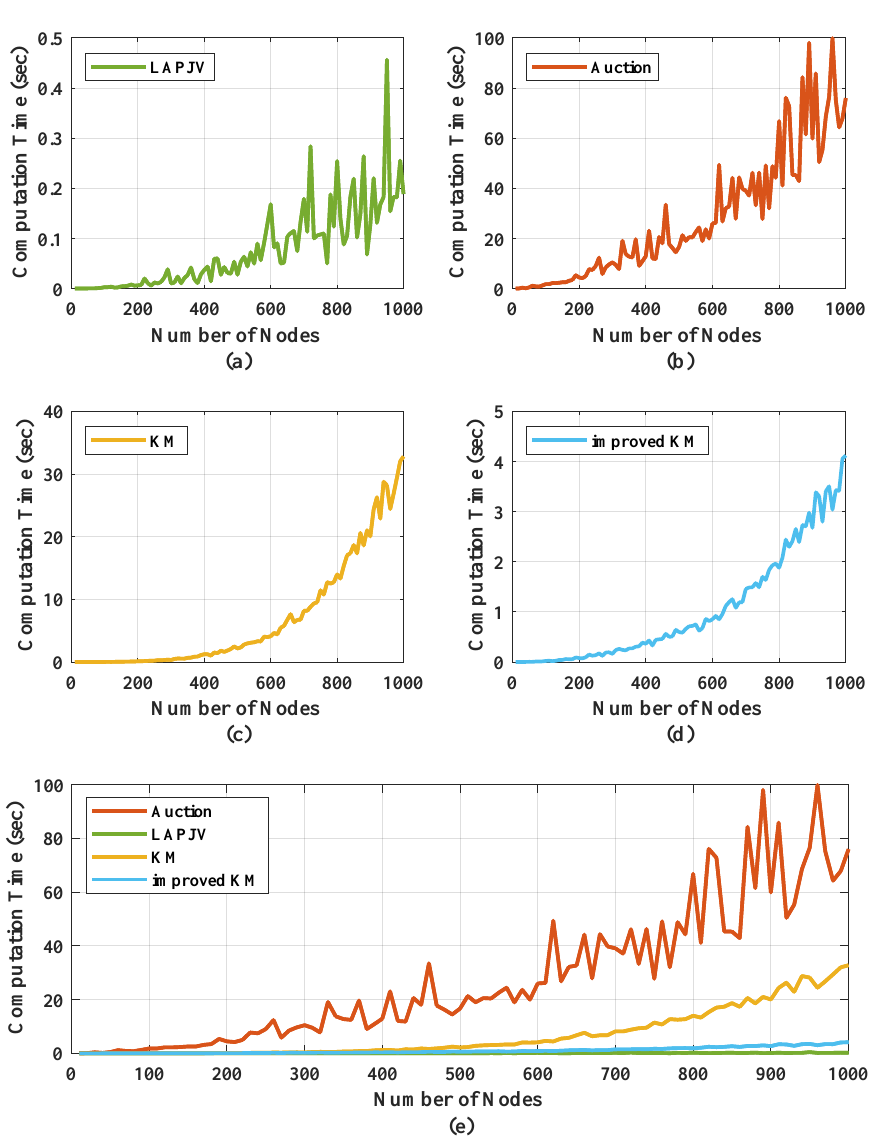
Figure 9. Computation time comparison between LAPJV, Auction, KM and improved KM as nodes varies from 10 to 1000. ( a ) Average computation time of the LAPJV algorithm; ( b ) Average com- putation time of the KM algorithm; ( c ) Average computation time of the improved KM algorithm; ( d ) Average computation time of the Auction algorithm; ( e ) Average computation time comparison of the four algorithms in the same